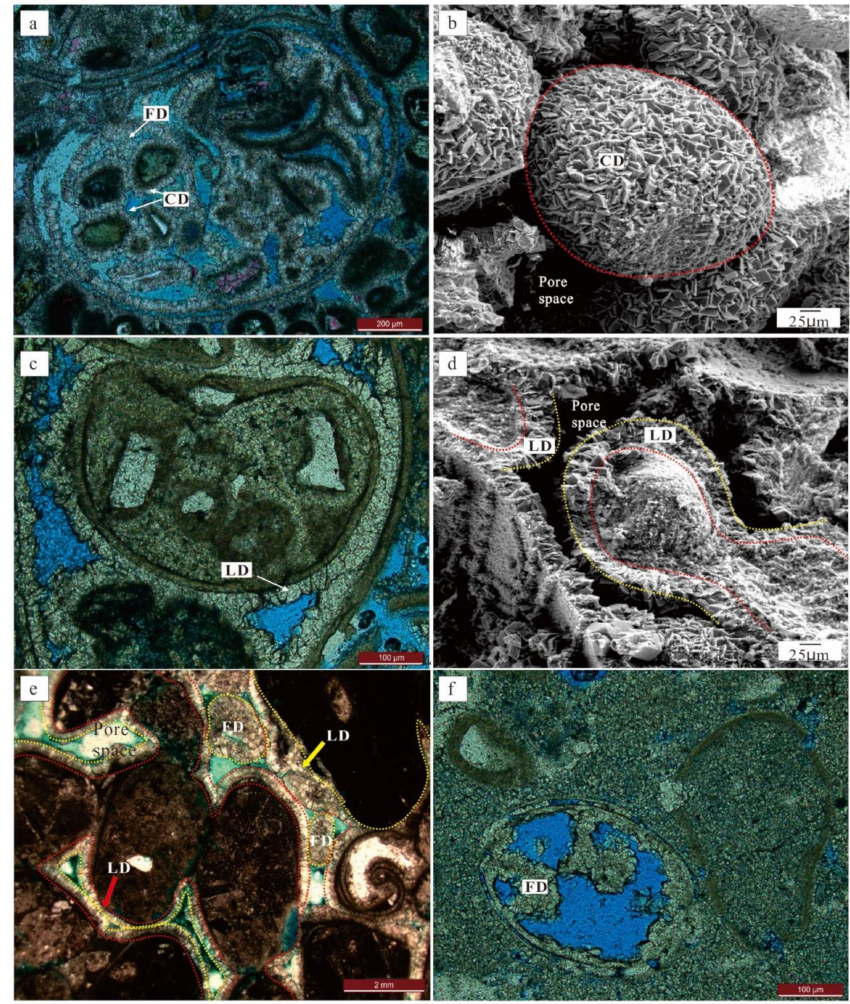
Figure 2. Optical thin sections and SEM images showing ( a ) crystalline coating dolomite (CD) wrapped around bioclastic grains in the form of isopachous cement and pore-filling dolomite (FD) in intergranular pores; ( b ) CD that clearly covers the surface of a peloid (energy spectroscopy: Mg: 3.67%, Ca: 5.13%, O: 49.68%); ( c ) Pore-lining dolomite (LD) developed around a moldic pore; ( d ) thin microcrystalline pore-lining dolomite (LD) that developed around various bioclasts (energy spectroscopy: Mg: 7.15%, Ca: 8.65%, O: 58.58%); ( e ) blade pore-lining dolomite (red arrow) with an isopachous rim that grew around intergranular pores, pendant pore-lining dolomite (yellow arrow) that is characterized by a distinct thickening of cement crusts beneath grains or under the roofs of intergranular and solution voids, and FD in intergranular pores; and ( f ) pore-filling dolomite (FD) in a moldic